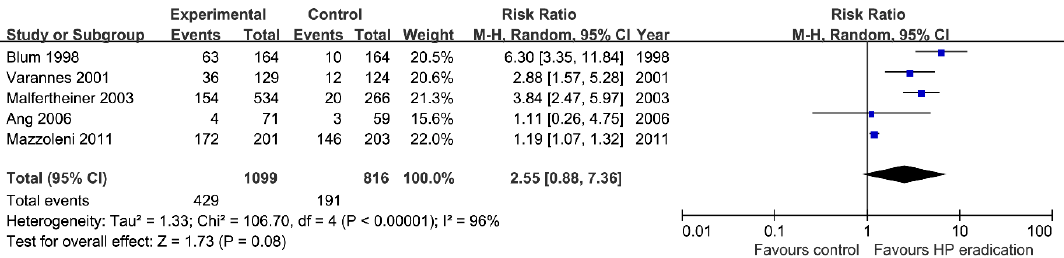
Figure 6. Forest plot of adverse effects associated with Helicobacter eradication therapy.